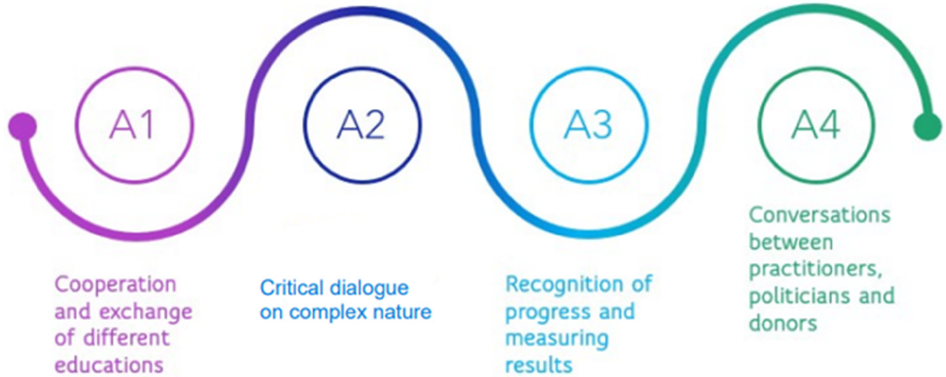
Figure 1. Action Generation Model According to the United Nations General Assembly .